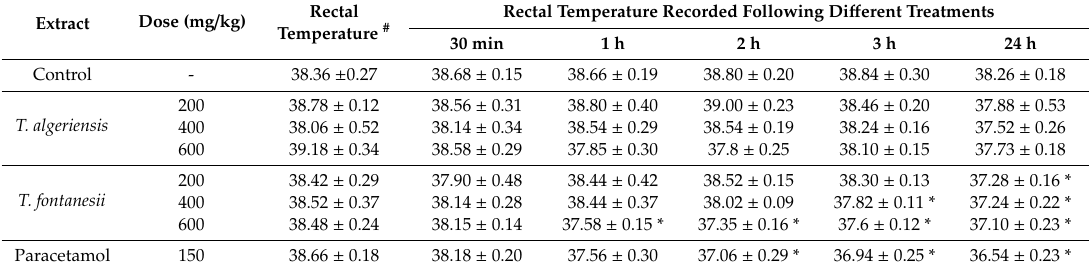
Table 3. E ff ect of T. algeriensis and T. fontanesii extracts on Brewer’s yeast induced pyrexia in mice. Rectal Rectal Temperature Recorded Following Di ff erent Treatments Extract Dose (mg / kg) Temperature # 30 min 1 h 2 h 3 h 24